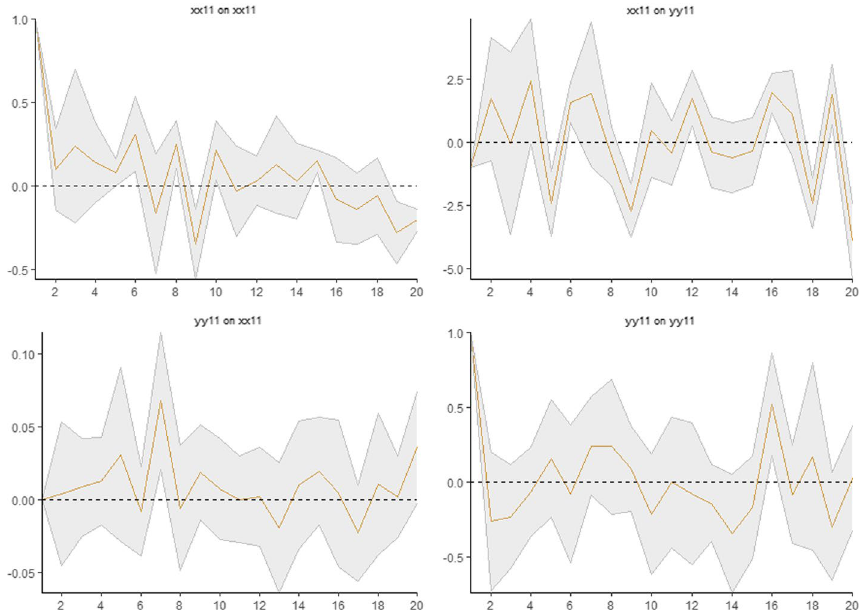
Fig. 9 The subperiod analysis of low-return regime for the period in which CPI > IR (Negative interest rates) (12.02.2019–05.12.2020)